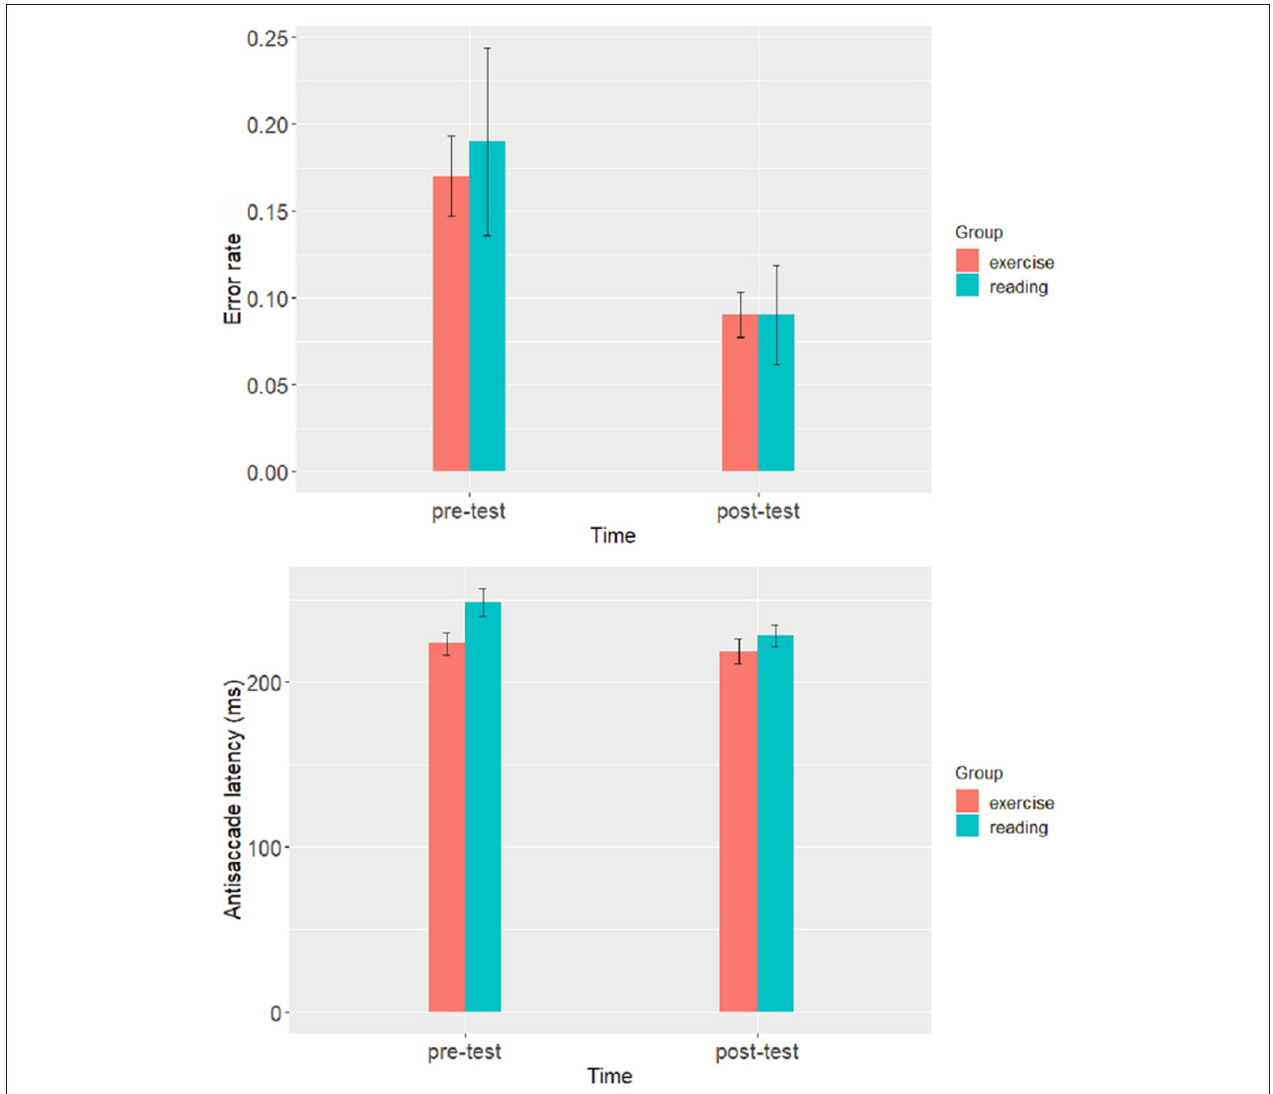
FIGURE 2 | Differences in saccadic eye movement measures in pre- and post-test antisaccade task for two groups of